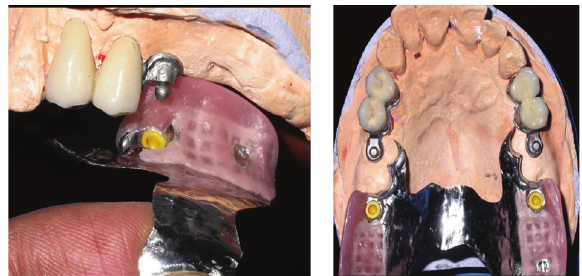
Figure 8: Acrylized prosthesis showing male and female O-ring attachment.